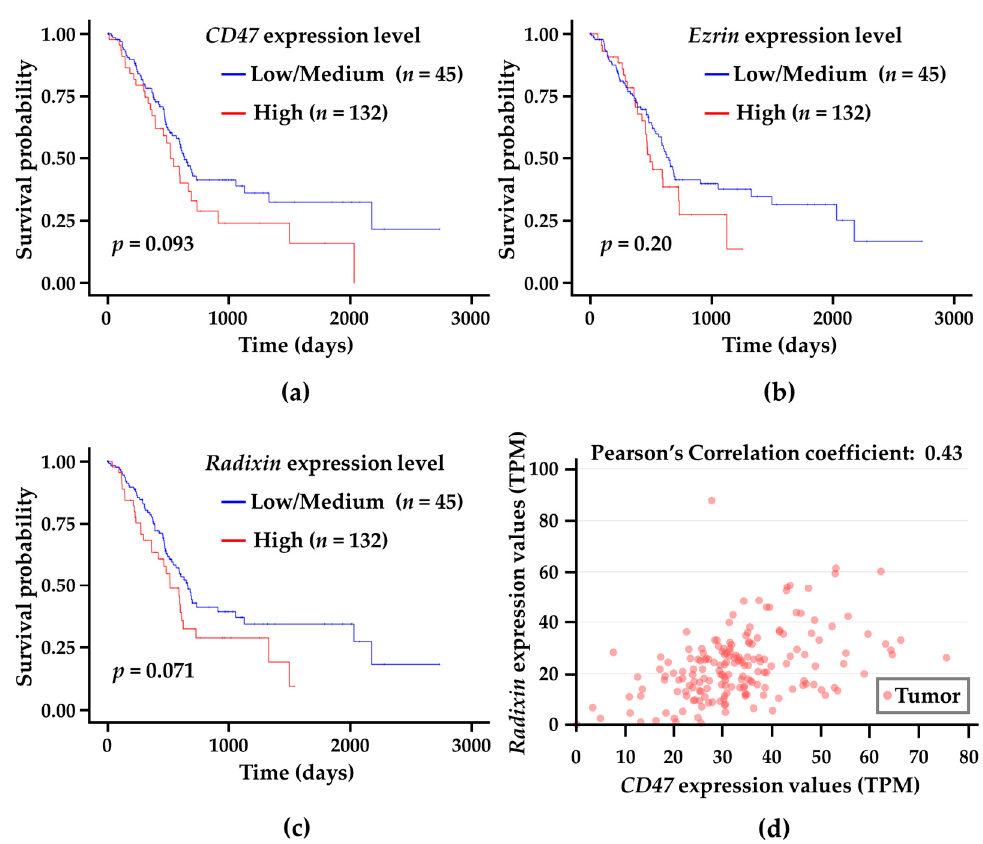
Figure 7. Correlation analysis for CD47 and ezrin / radixin gene expression levels in tumor tissues with survival probability for patients with PDAC. ( a – c ) Survival probability curves for the patients with PDAC who had high ( n = 132) or low/medium ( n = 45) expression levels of CD47 , ezrin , or radixin , respectively, as assessed by the Kaplan–Meier method using UALCAN. ( d ) Correlation analysis for the gene expression values of CD47 with radixin in the clinical PDAC tissues ( n = 179) from The Cancer Genome Atlas (TCGA) database. The estimated gene expression values based on RNA-seq data are represented as TPM.